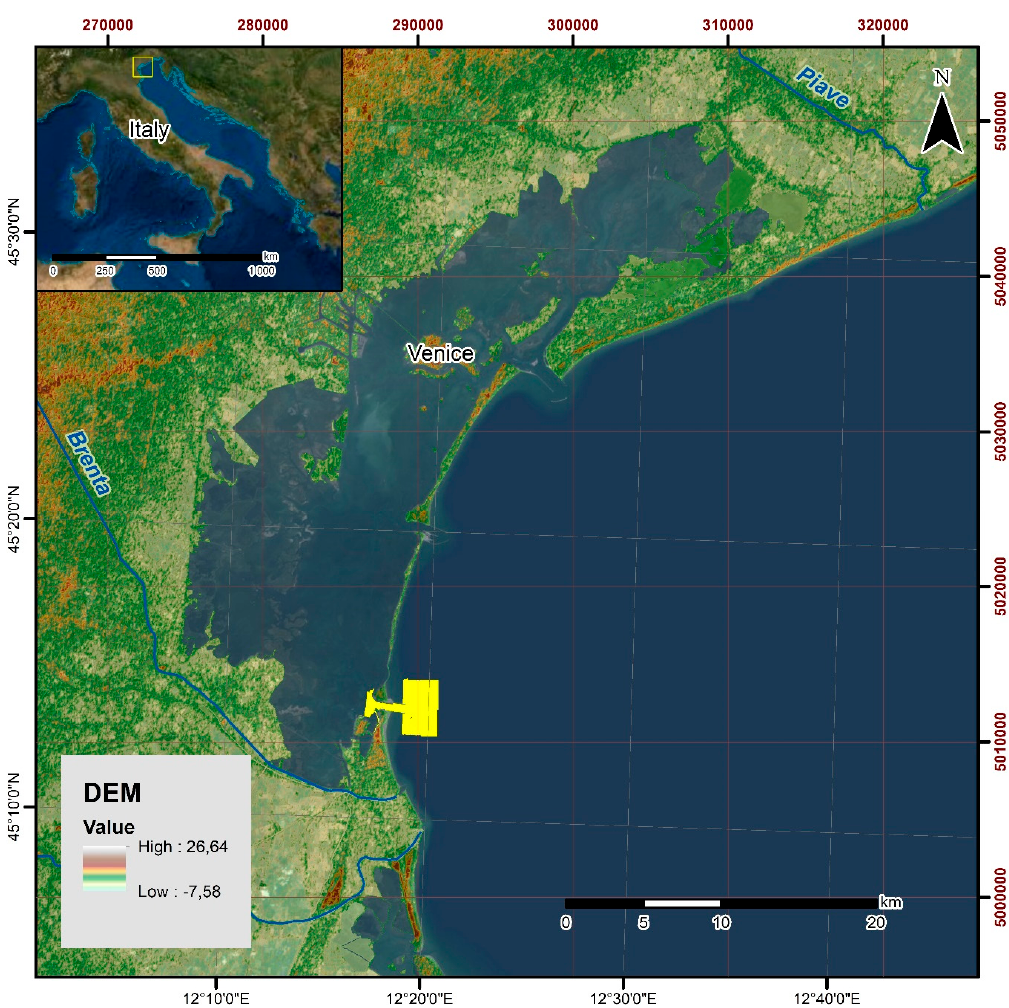
Figure 1. Geographical setting of the Lagoon of Venice with marked inlet (yellow) and main rivers. DEM—digital elevation model.